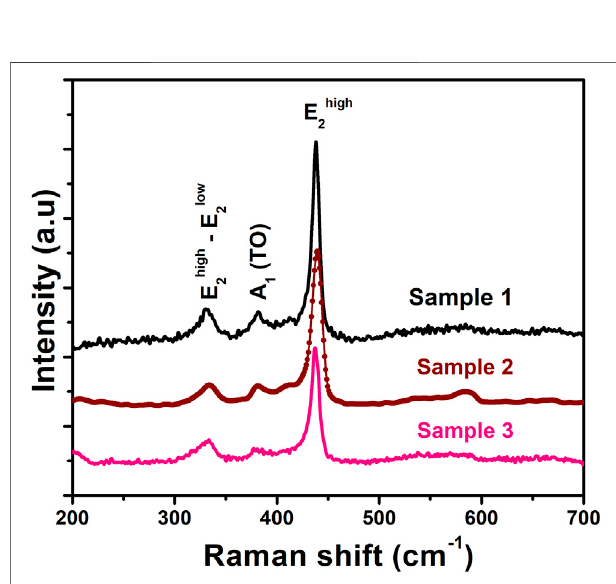
FIGURE 3 | Raman spectra of ZnO nanosheets for sample 1, sample 2, and sample 3.